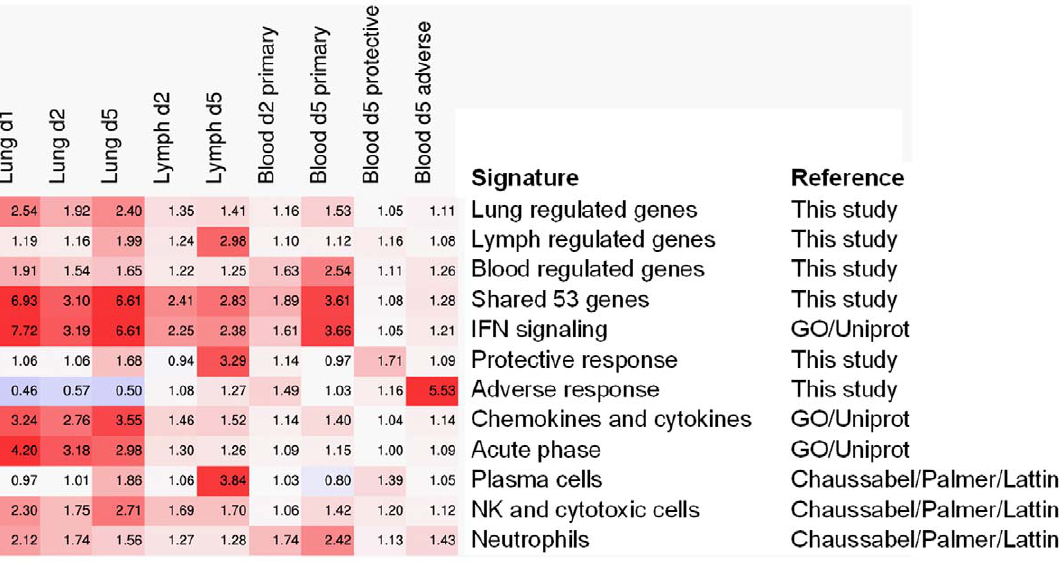
Figure 3. Module comparison of expression responses. Figures indicate the median response per module. Background color indicates the extent of up- (red) or down-regulation.